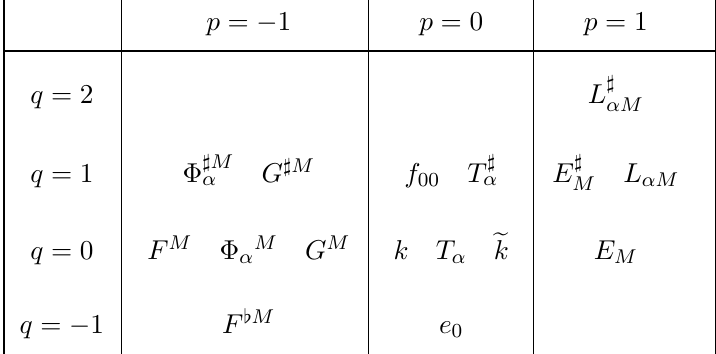
Table 3 . Basis elements for W ( g + ) at p = (cid:0) 1 ; 0 ; 1.